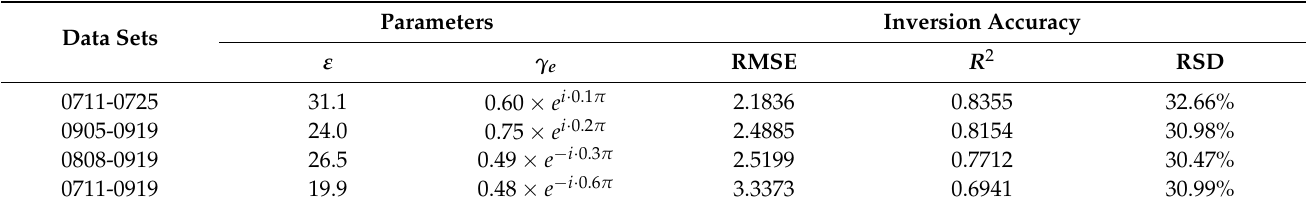
Figure 14. Scatter plots of the height inversions based on the improved model and prior true height. RMSE and x are the root mean square error and the mean value of the inversion results, respectively. Table 3. Iteration parameters and inversion